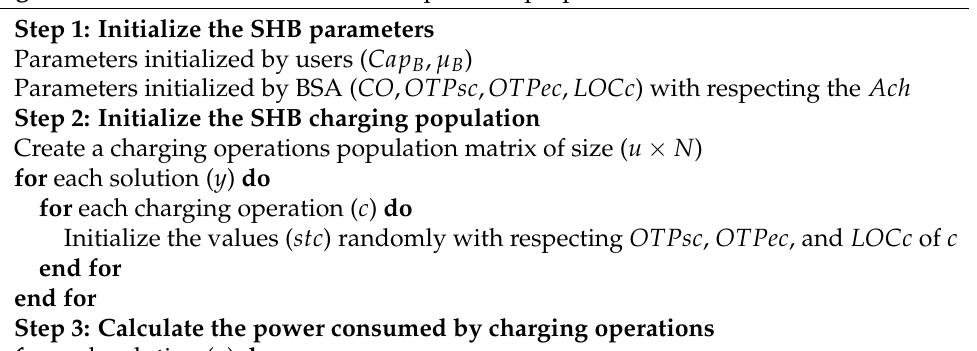
Algorithm 5 Pseudocode of the four steps of the proposed